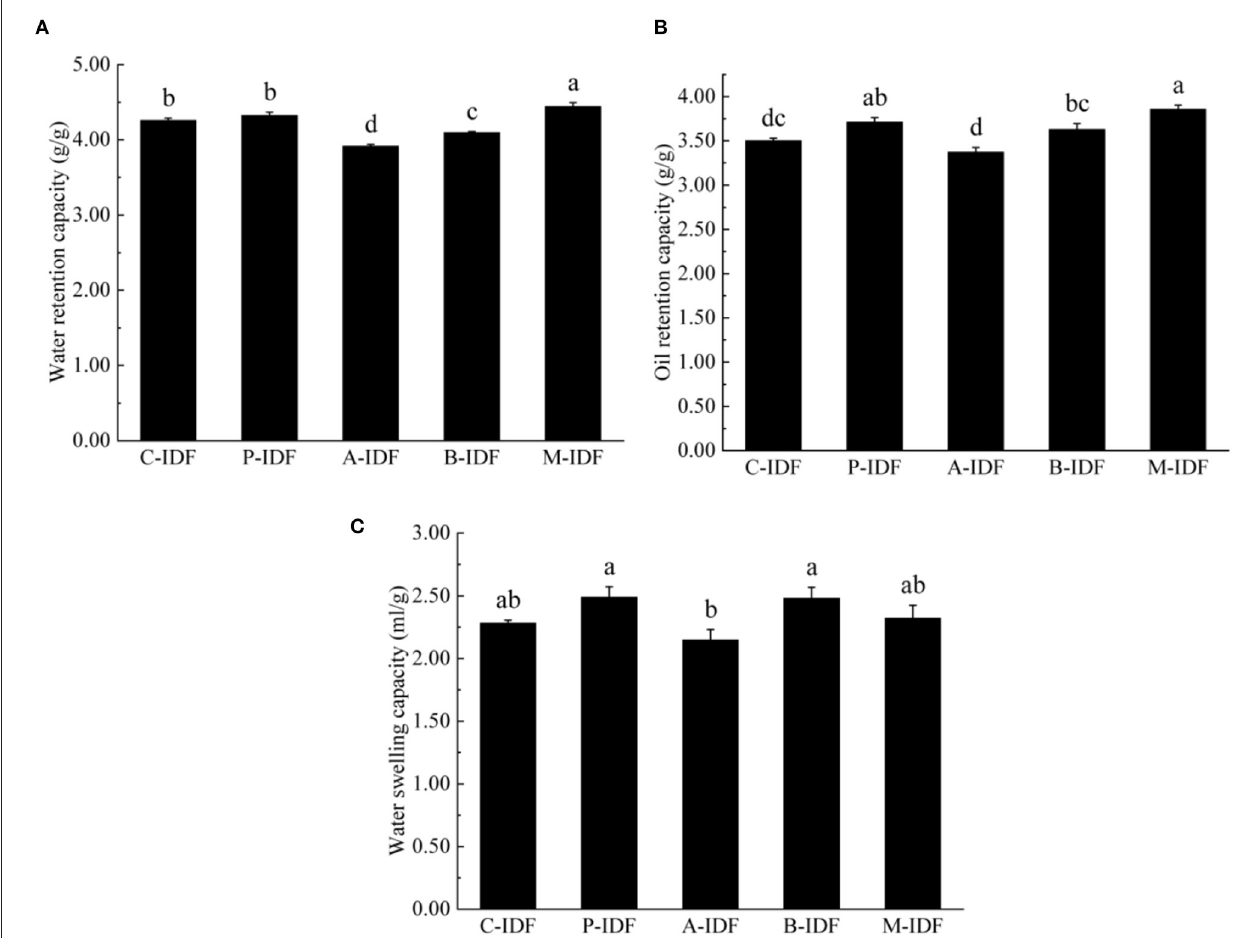
FIGURE 4 | Physicochemical properties of W-IDF. (A) Water retention capacity (WRC), (B) oil retention capacity (ORC), (C) water swelling capacity (WSC). Data were expressed as means ± SD with different letters representing significant difference ( p <